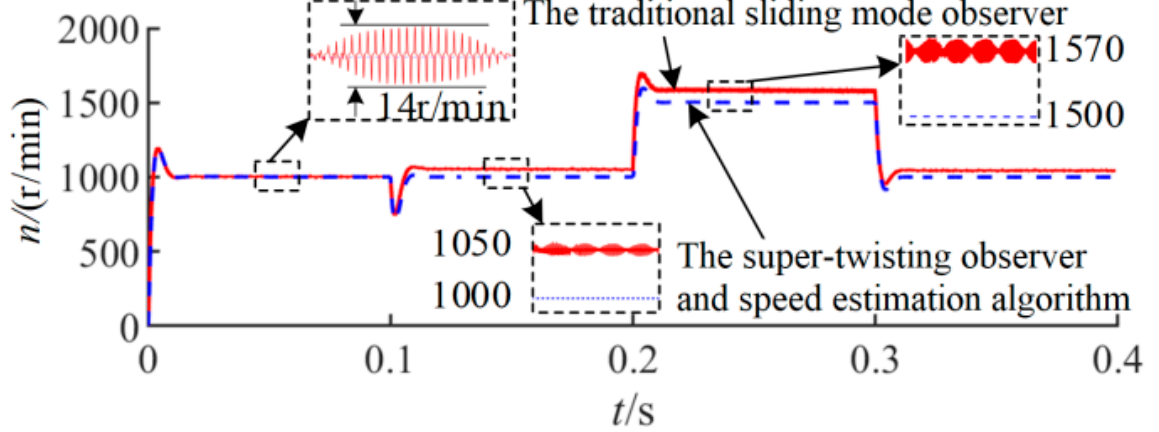
Figure 2. Simulation curves of speed for the two observers.